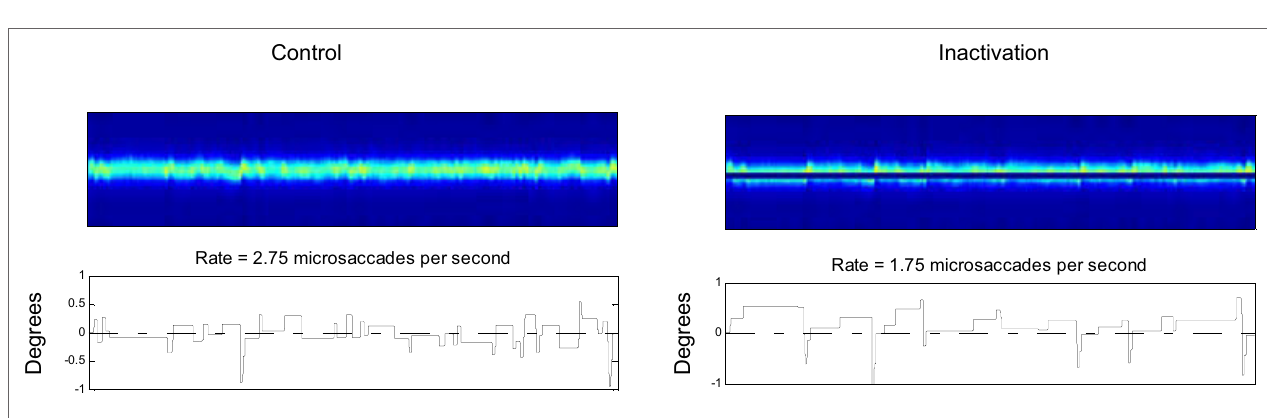
FigUre 7 | Simulated microsaccade distributions. (a) Peak velocity/magnitude relationship. (B) Distribution of microsaccade magnitudes. (c) Distributions of microsaccade displacements (negative corresponds to amplitude toward the left and positive to amplitude toward the right). (D) Distribution of intersaccadic